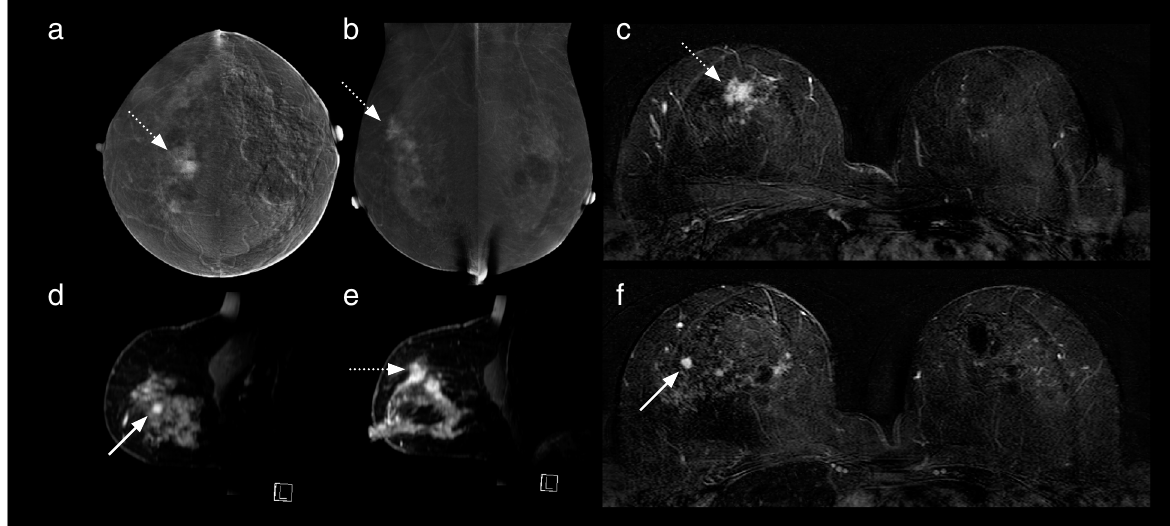
Fig. 3 Case number 1 of Table 3. A 64-year-old woman presented with a calcified right breast mass at 12 o’clock on screening mammography, a grade 3 infiltrating ductal carcinoma. CC ( a ) and MLO ( b ) recombined CEM images show an enhancing spiculated mass (dotted arrows). Enhancing satellite foci are also visible on the MLO projection. MRI axial ( c , f ) and sagittal ( d , e ) contrast-enhanced T1-weighted subtracted images show the dominant lesion (dotted arrows) and an additional enhancing lesion solid (solid arrows) 2 cm infero-laterally. No corresponding finding was detected laterally on CEM. Mastectomy revealed a multifocal grade 3 invasive ductal carcinoma, oestrogen-, progesterone- and Her2 receptor-positive, with associated high-grade ductal carcinoma in situ . The additional lesion was a grade 2 invasive ductal carcinoma. CC Craniocaudal, CEM Contrast-enhanced mammography, MLO Mediolateral, MRI Magnetic resonance imaging